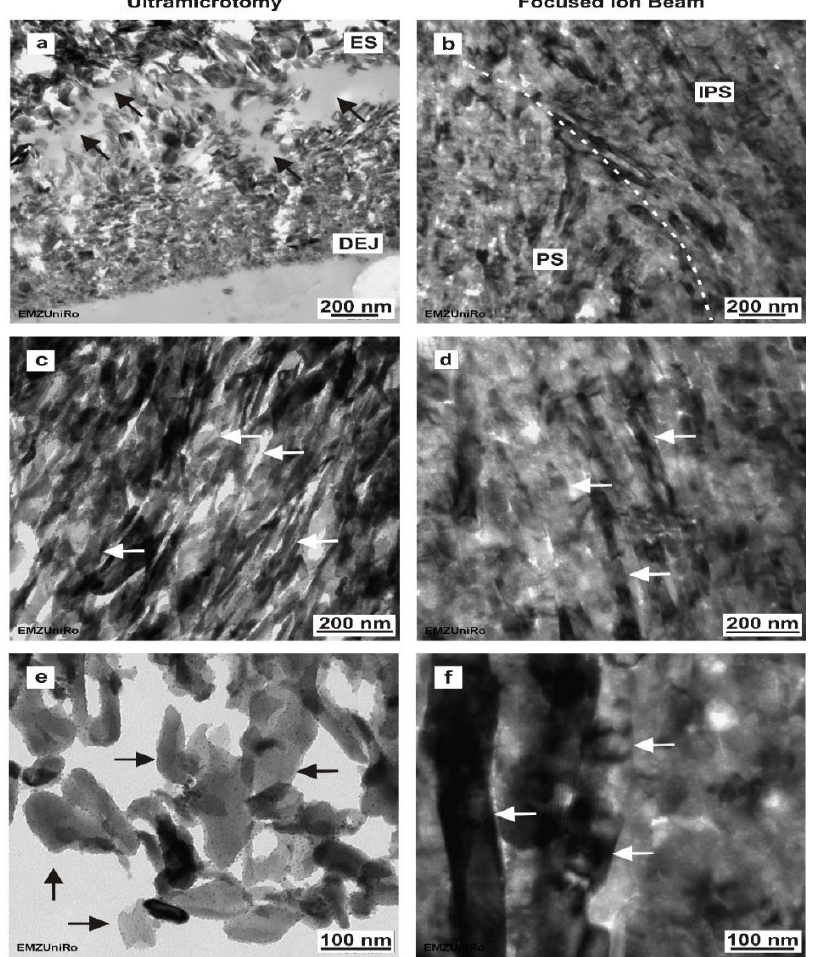
Figure 3. Comparison of ultramicrotome and in situ FIB lift-out-prepared human mineralized enamel. ( a ) Ultramicrotome-prepared enamel section depicting the increasing size gradient of enamel hydroxyapatite crystals towards the outer enamel surface (ES). Delamination of the